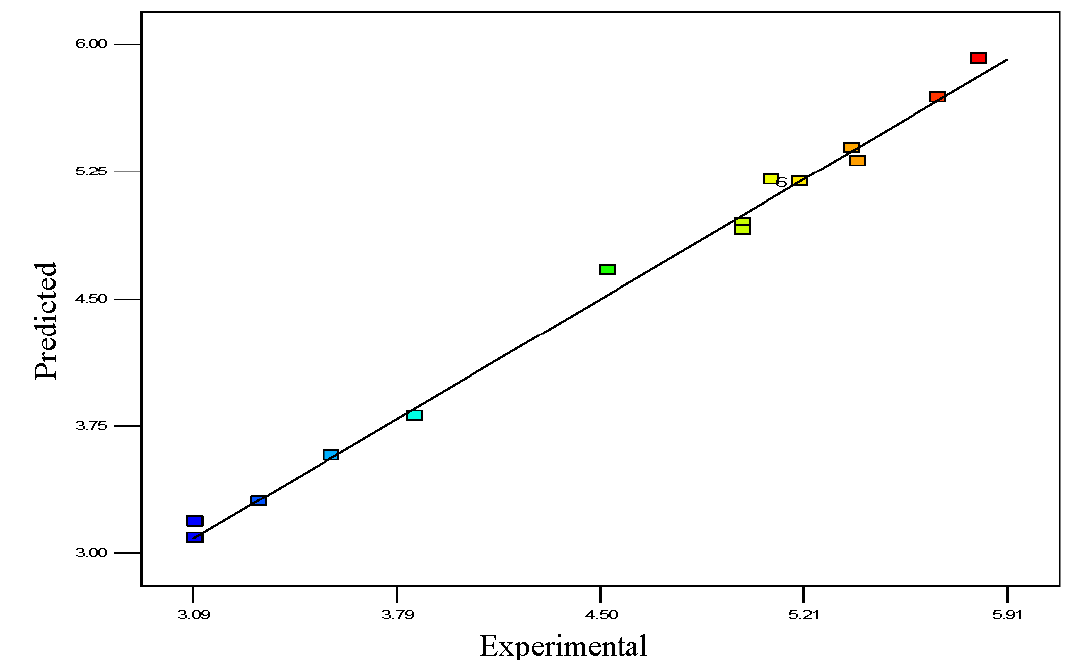
Figure 4. Linear correlation between actual and predicted